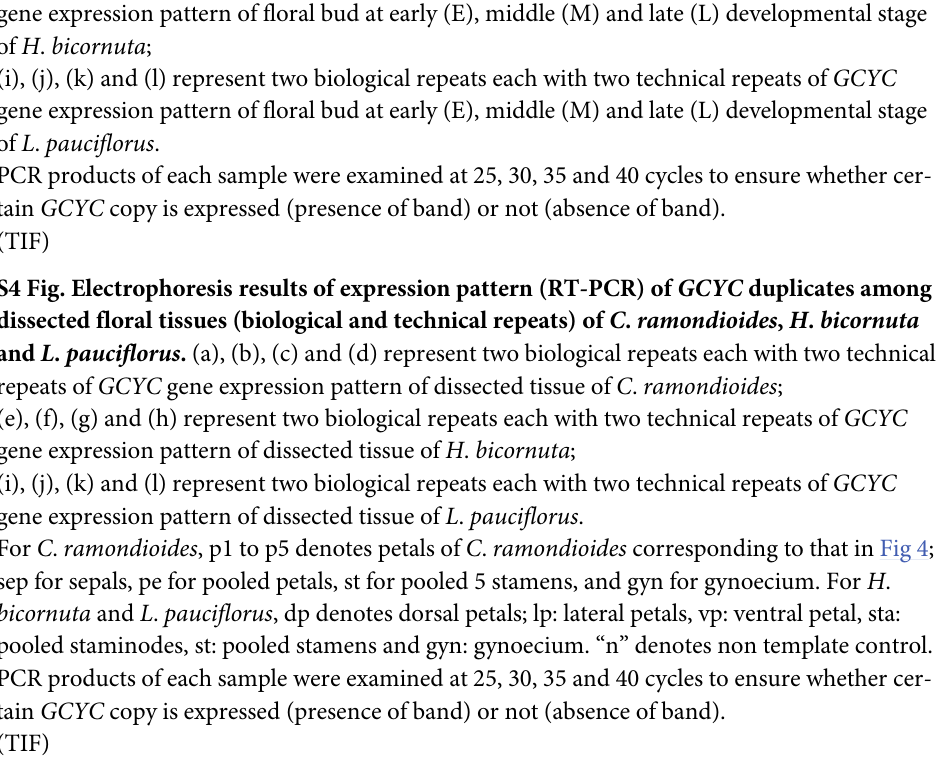
S5 Fig. Primer dimer identified from gel picture of amplification of CrCYC1C of C .